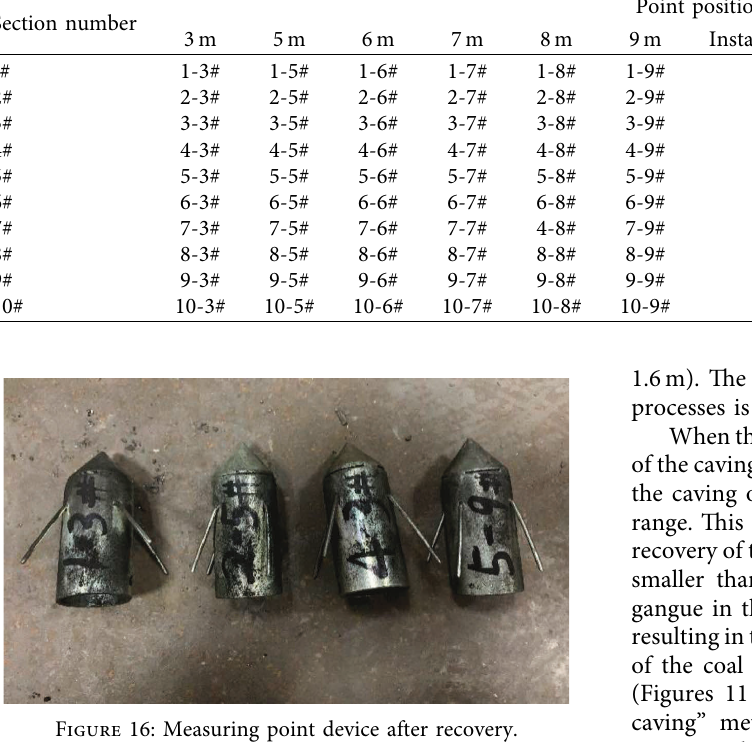
4# supports after closing the outlets of the 1# and 2# sup- ports. The mode described is followed until all supports have completed caving. The coal caving direction in the above model is from top to bottom along the dip of coal seam.